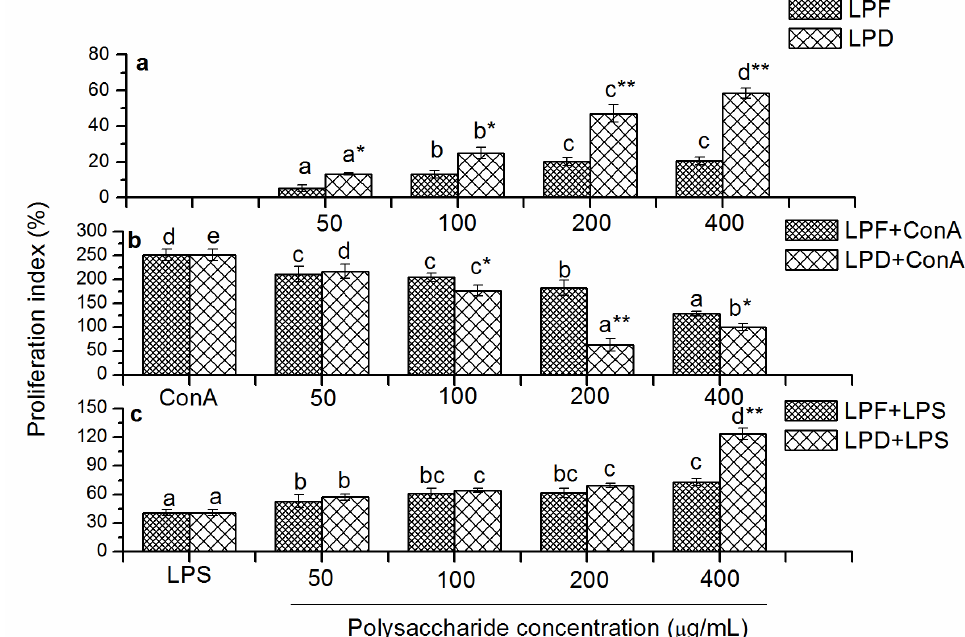
Figure 3. Effects of the litchi polysaccharides LPF and LPD on the proliferation index of splenocytes ( a ), ConA-induced splenocytes ( b ) and LPS-induced splenocytes ( c ) at different concentrations (0, 50, 100, 200 and 400 μ g/mL). The proliferation indexes were assessed by the MTT assay and expressed as the mean ± standard deviation ( n = 6). Bars labeled with different letters represent a statistical difference at p < 0.05 among different concentrations of the same sample. ( * ) 0.01< p < 0.05 and ( ** ) p < 0.01 compared with